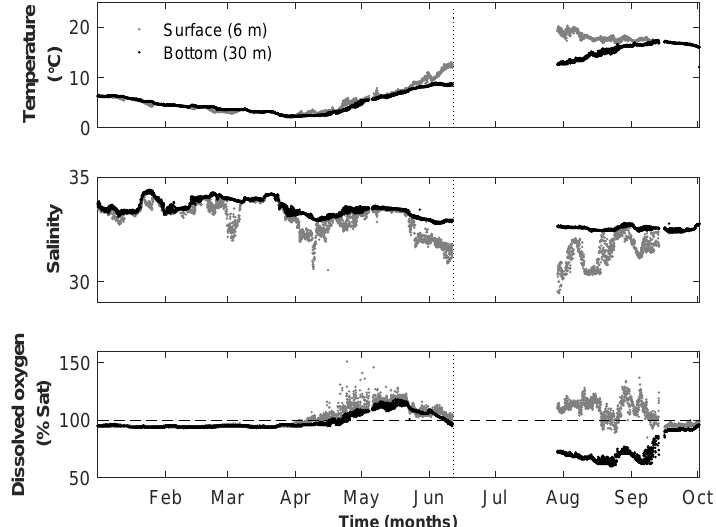
Figure 13. Surface (6m, gray) and bottom (30m, black) temperature, salinity and dissolved oxygen (% saturation) measured at the Deutsche Bucht station (Fig. 1, Table 1), part of the MARNET monitoring network. The data cover a time frame between January and October 2013. The onset of the June flood is marked by a vertical line.